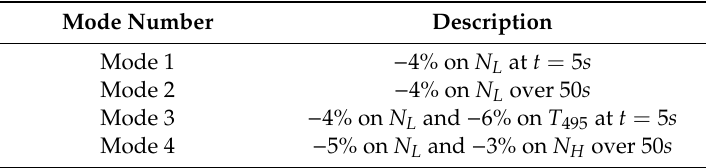
Table 2. Descriptions of 4 fault modes.